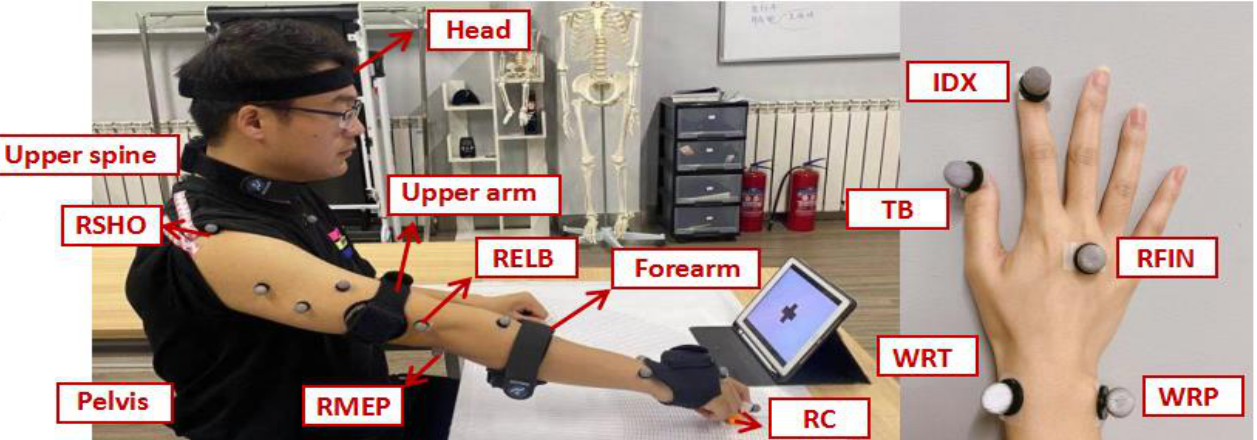
Figure 3. Illustration of marker and IMUs placement. The person permitted the use of this image.